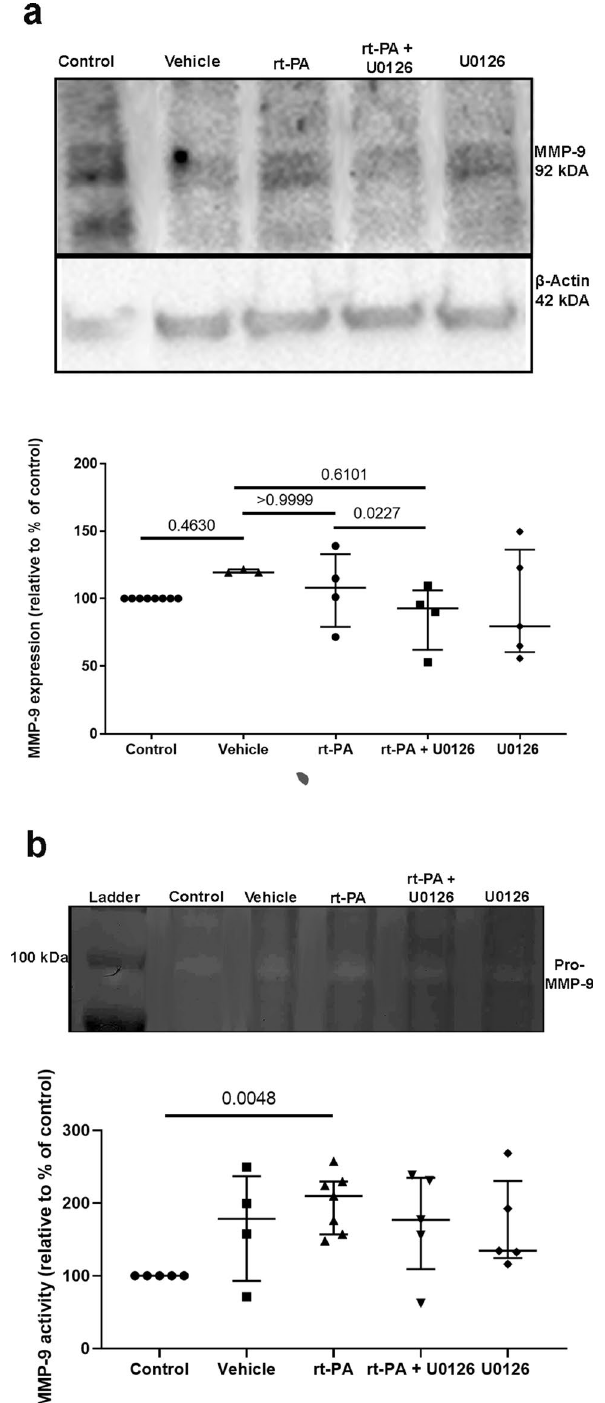
Figure 3. Combination treatment with rt-PA + U0126 prevents the increased MMP-9 expression after delayed rt-PA treatment. ( a ) Representative western blots and scatter plots displaying expression of MMP-9.MMP-9 expression levels were normalized to control. ( b ) Representative zymography blots and scatter plots illustrate MMP-9 protein expression. The expression levels were normalized to control group which was set to 100%. All data are presented as median ± IQR, *P < 0.05 is considered statistically significant, n =